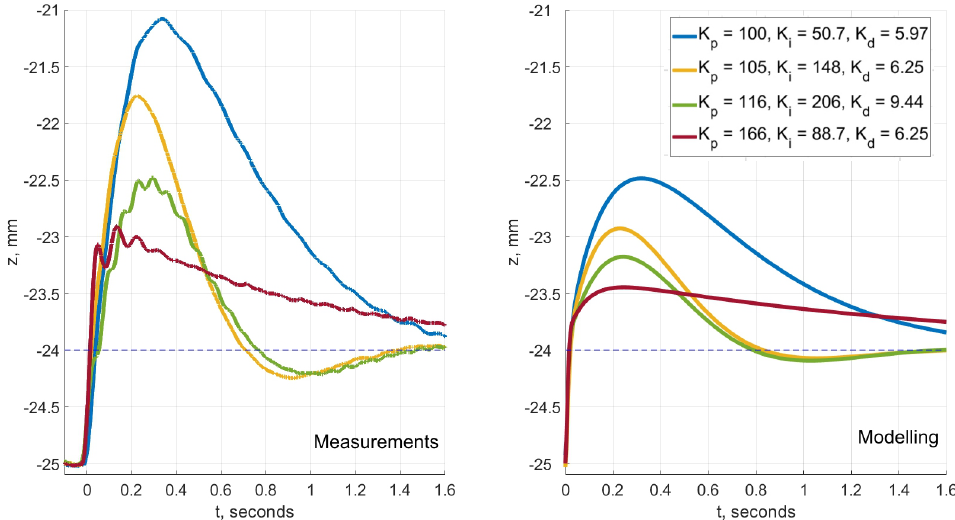
Figure 14. A comparison of a sequence of measured and modeled responses with reducing overshoot. Overall, the modeling is consistent with the experiments. The key feature influencing the compliance of the data is the accuracy of the used expression for the magnetic force. As expected, with larger values of overshoot (blue and yellow curves) the model becomes less accurate. The difficulties involving the nonlinearity identification of the magnetic force of the coil applied to the permanent magnet in a form of a small cylinder are discussed in the corresponding